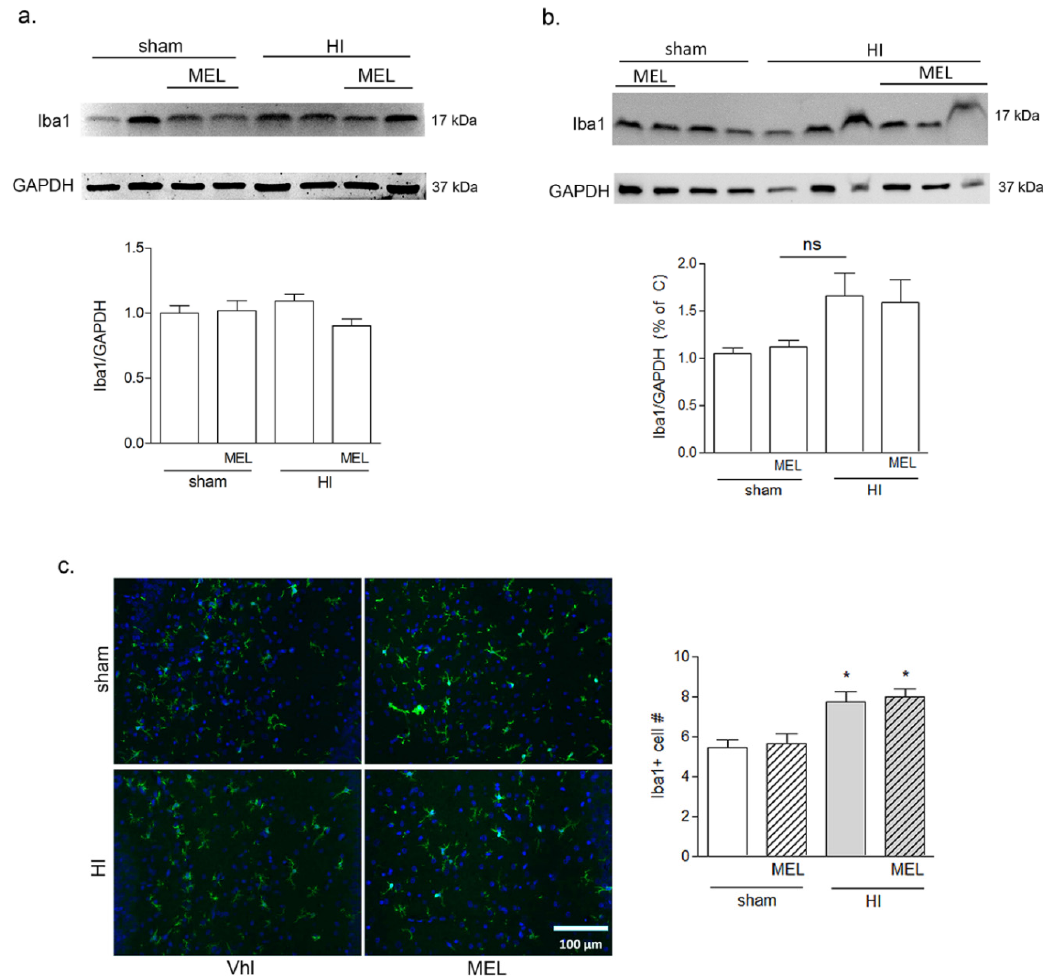
Figure 8. Melatonin does not affect Iba1+ cell number in rats subjected to CCAO. Seven-day-old rats were subjected to sham surgery or to ligation of the right carotid artery followed by hypoxia. Melatonin-treated groups were subsequently injected with melatonin (10 mg/kg) and sacrificed after 24 h. Iba1 expression in ipsilateral cortical ( a ) and hippocampal ( b ) protein extracts was evaluated by Western blot analysis. Microglia were labeled by immunohistochemical staining of Iba1 (green, c ) with DAPI nuclear counterstaining (blue, c ). Double positive Iba1+/DAPI+ cells were counted in the CA1 area of the hippocampus (HC; graph in c ). Bars are mean ± SEM of at least three animals/group. * p < 0.05 vs. sham by one-way ANOVA followed by Newman–Keuls test for statistical significance. Representative images of blots and of ipsilateral HC are shown. Scale bar = 100 μ m.